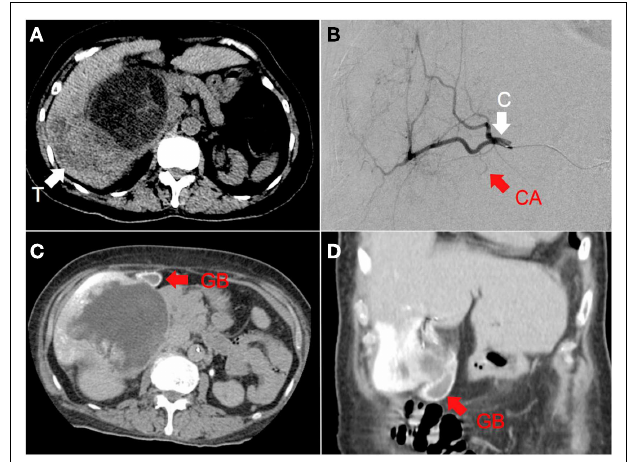
FIGURE 4 | (A) Hepatocellular carcinoma of the right lobe (“T”) in a background of polycystic kidney and liver disease, seen on non-contrast-enhanced CT. (B) RE was performed with the catheter tip (“C”) in the right hepatic artery, proximal to the origin of the cystic artery (“CA”), seen here on digital subtraction angiography (C,D) Catheter-directed CT hepatic angiogram of the right hepatic artery demonstrates prominent contrast enhancement of the gallbladder wall (“GB”).